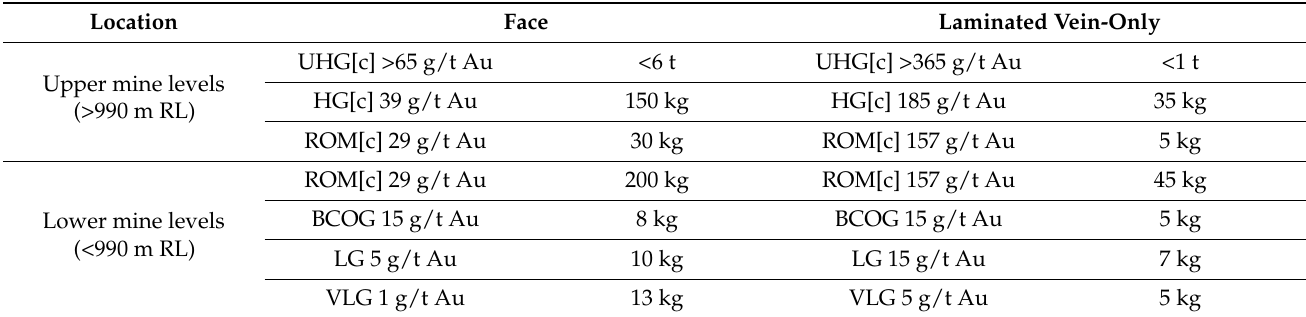
Table 24. Summary of RSM values for key scenarios.